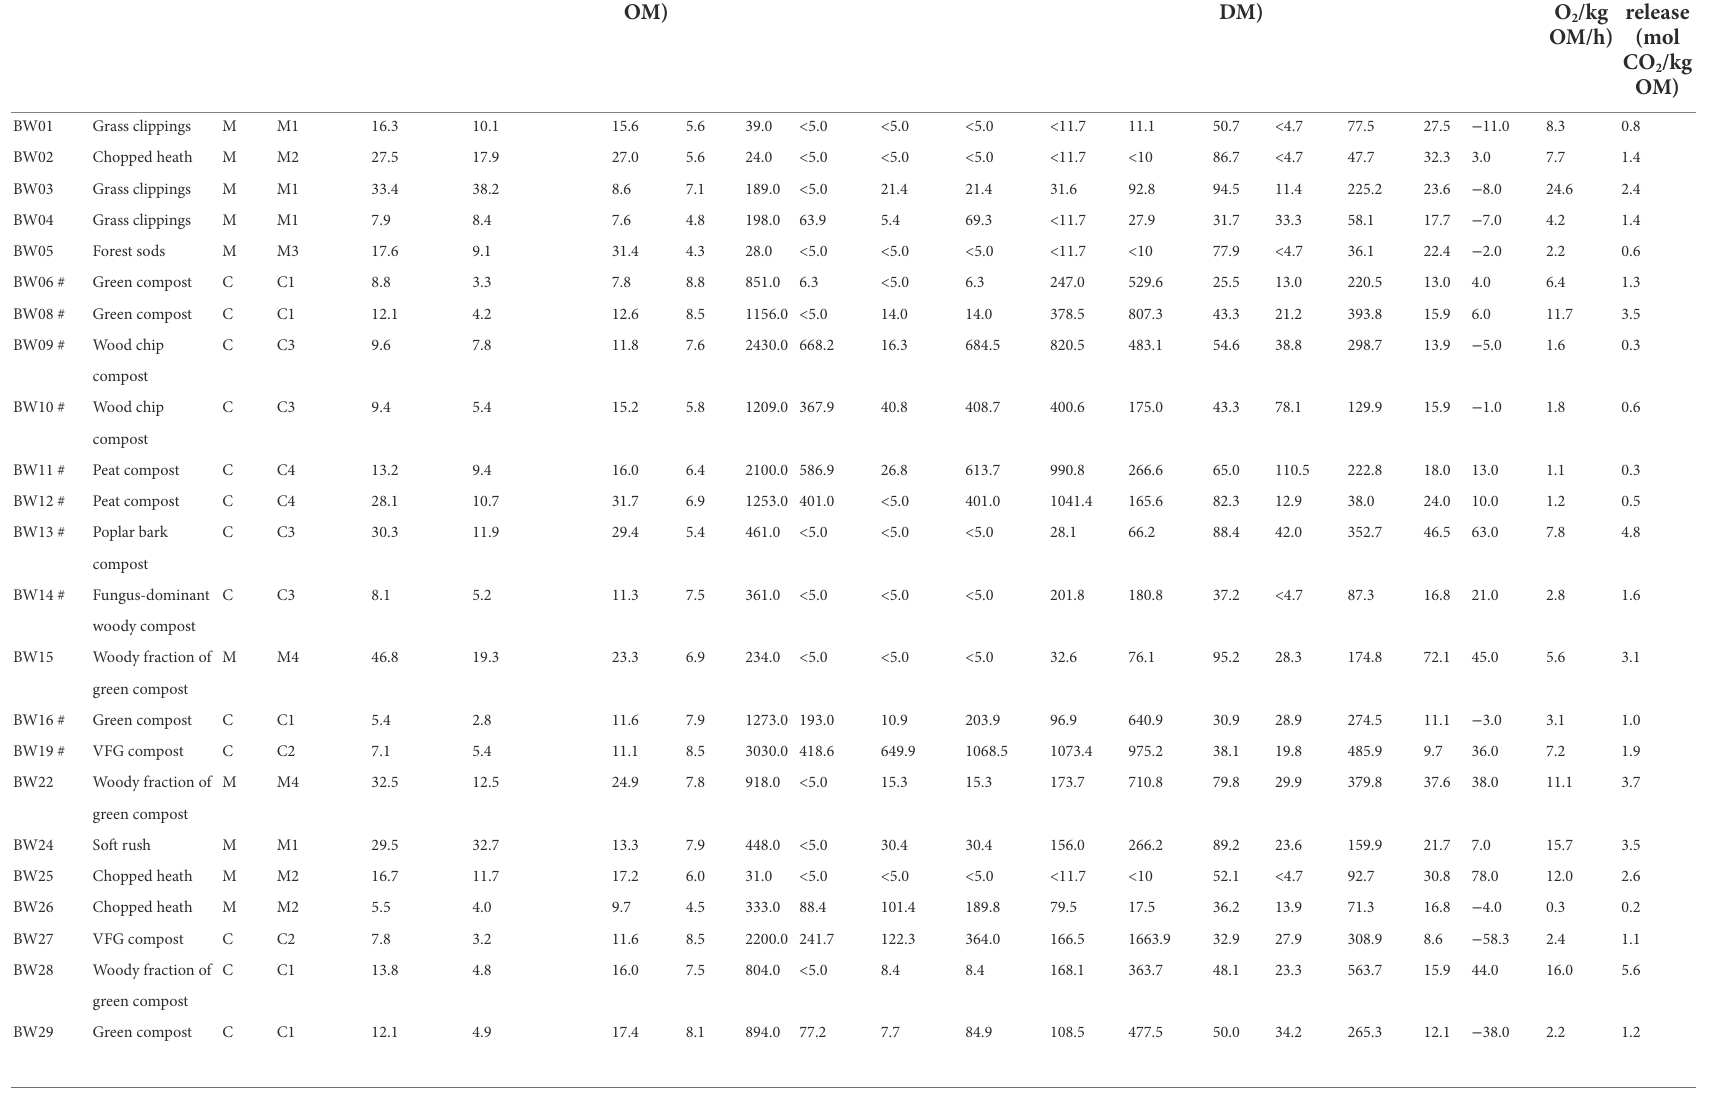
TABLE 1 (Bio)chemical characteristics of the different samples of composts (C), management residues (M) and peat-based substrates